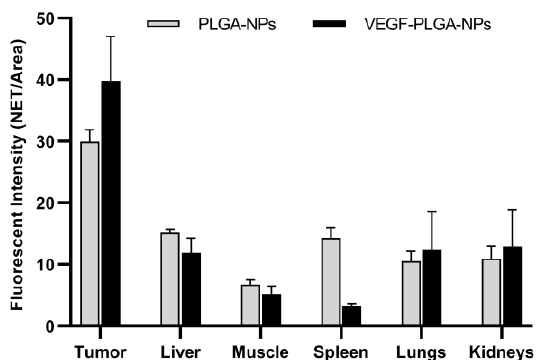
Figure 6. Whole body images of two mice bearing a syngeneic J744a.1 tumor in the right thigh and acquired 24 h post-injection (p.i.) of native PLGA-NPs (left) and VEGF-PLGA-NPs (right).